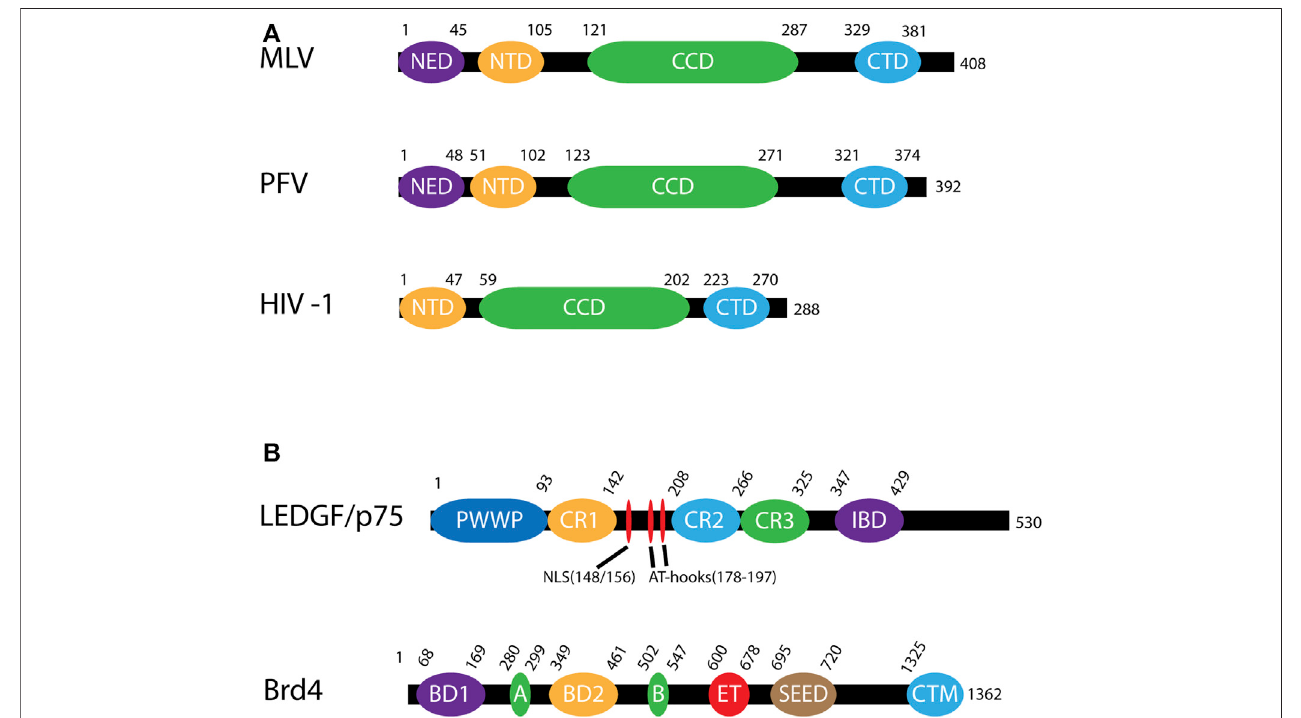
FIGURE4| Domainsofviralintegrasesandcofactors. (A) Domainsofmurineleukemiavirus(MLV),prototypefoamyvirus(PFV)andhumanimmunode fi ciencyvirus (HIV-1)INs.Thesedomains aretheN-terminalextension domain (NED),theN-terminaldomain (NTD),thecatalytic coredomain (CCD)andtheC-terminaldomain(CTD). The numbers along each linerepresent amino acid residues. (B) Domains ofintegrationhost cofactors LEDGF/p75and Brd4. LEDGF/p75 includes a chromatin binding domain(PWWP)followedbythreechargedregions(CR1-CR3).BetweenCR1andCR2isanuclearlocalizationsignal(NLS)andtwoAT-hookswhichallowforDNA binding of AT-rich motifs. Near the C-terminus is the integrase binding domain (IBD). Brd4 contains two bromodomains (BD1, BD2) as well as 2 DNA binding motifs, A and B, which in conjunction bind chromatin. There is also a protein interaction extra terminal domain (ET), a serine-rich SEED domain, and a C-terminal motif